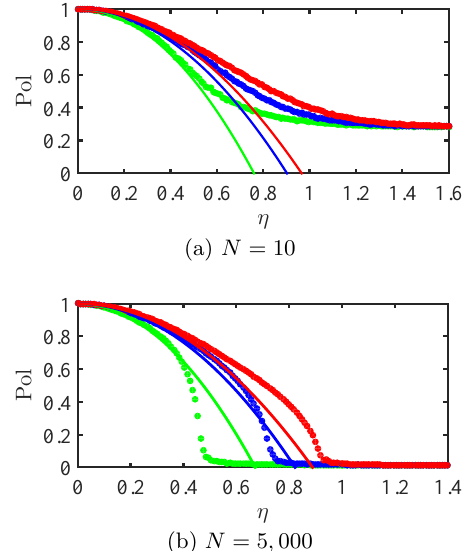
Figure 5: Polarization as a function of the noise scaling factor η for small (a) N = 10 and large (b) N = 5 , 000 networks with α = 1 . 71 , λ = 0 . 1 and γ = 1 . The number of connected neighbors is set as follows: K = 2 in green, K = 4 in blue, and K = 8 in red. Dots are numerical simulations, and solid lines are analytical predictions from Eq. (20) . For the small network, the plateau is reached at Pol ≃ 0 . 28